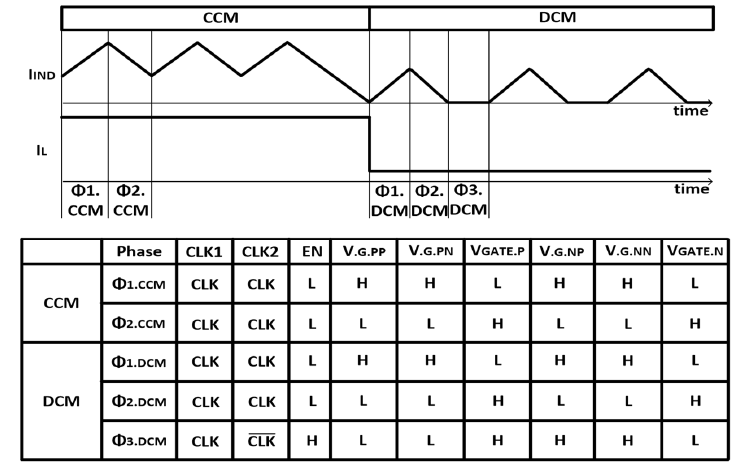
Figure 8. Operation of the proposed gate driver in continuous circuit mode (CCM) and discontinuous circuit mode (DCM) conditions.